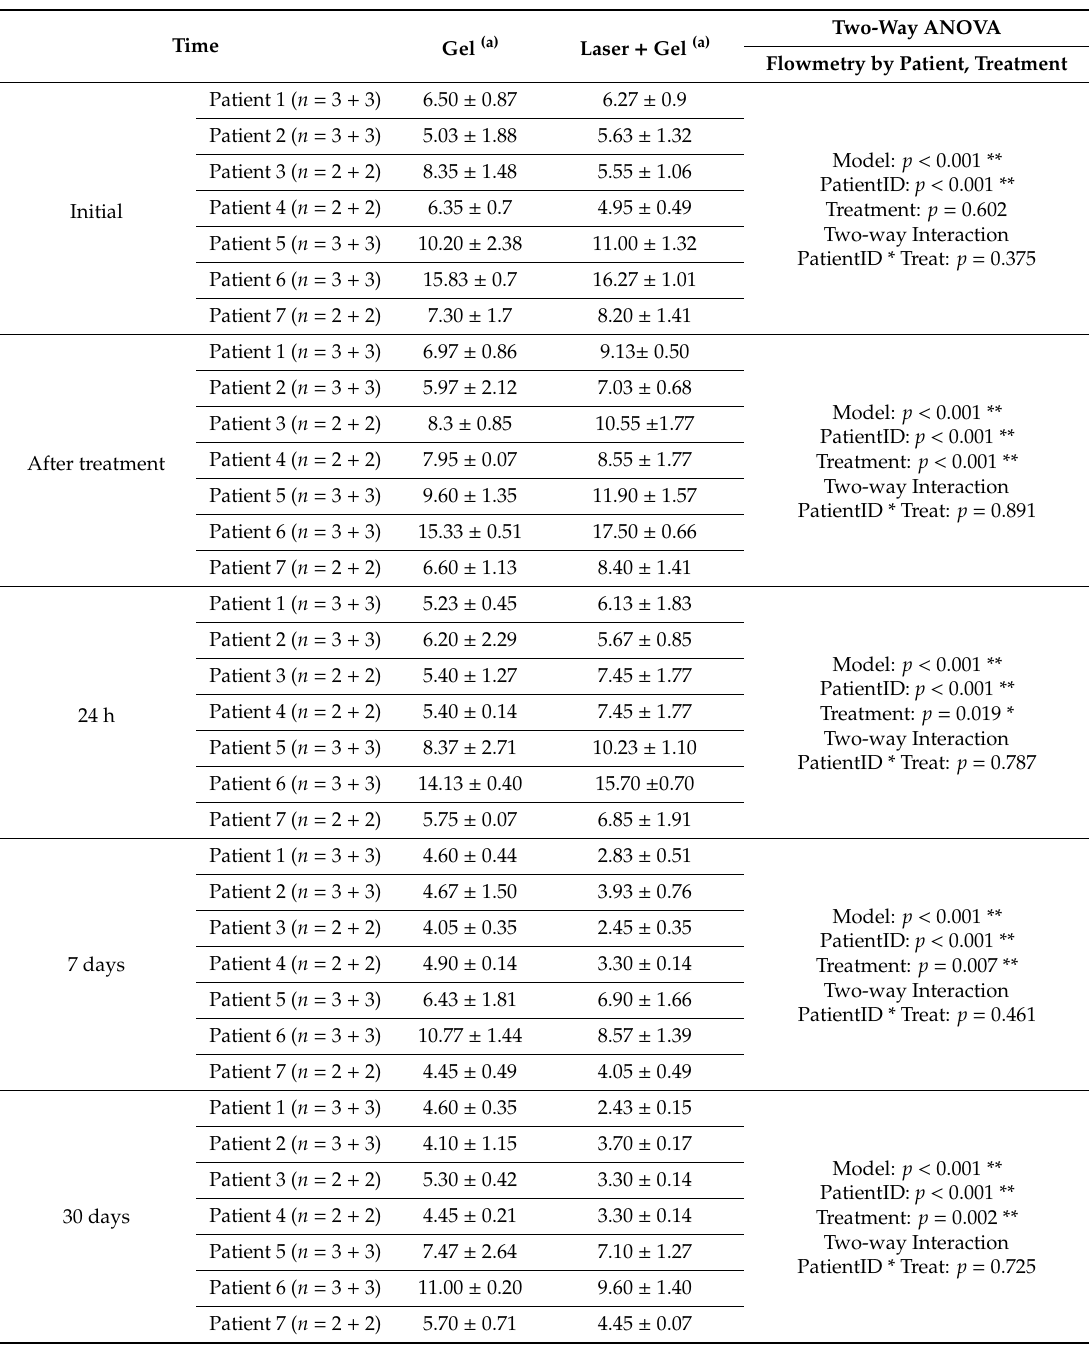
Table 6. Descriptive statistics of flowmetry values in the laser-Doppler 1.5 min recordings for the seven patients enrolled in this split-mouth